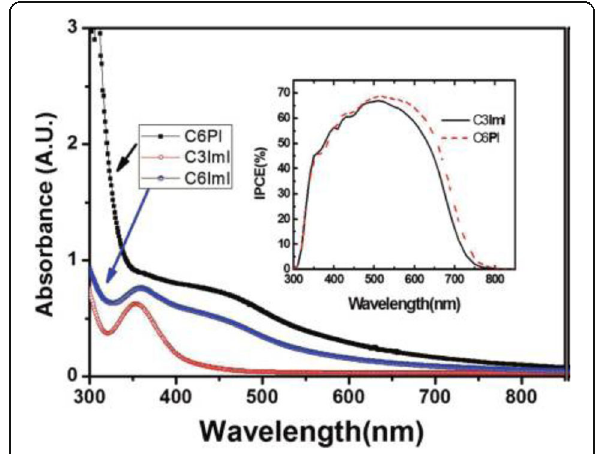
Fig. 11 UV-vis spectroscopy selected pyridinium and imidazolium salts. The inset is the IPCE data for the cells with EC3ImI and EC6PI, which are the best cells among each series